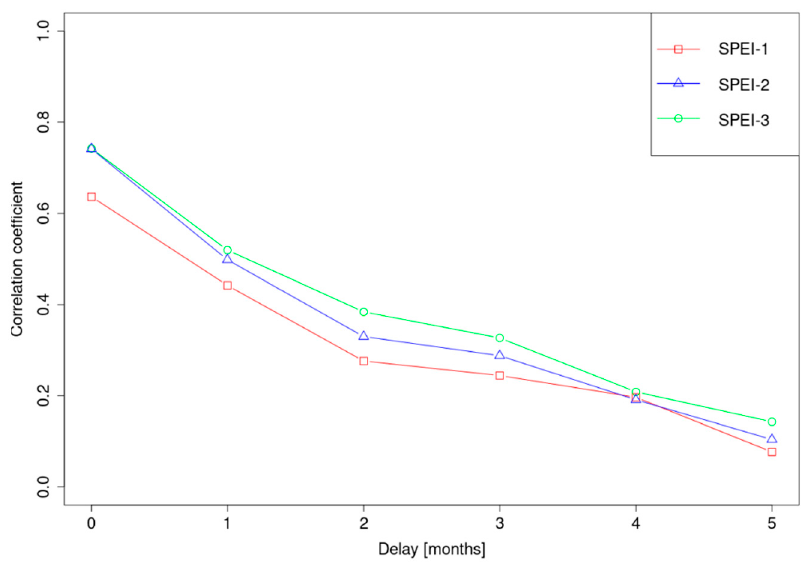
Figure 4. Correlation between SPEI and SSI for station 5018 with different SPEI delays and accumulation periods.